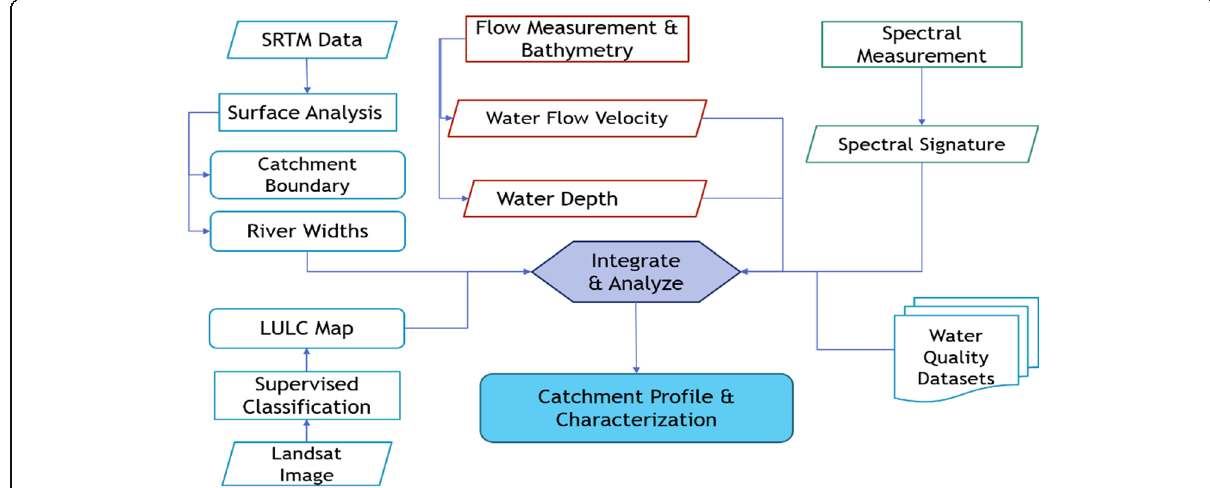
Fig. 2 The methodological flow of the